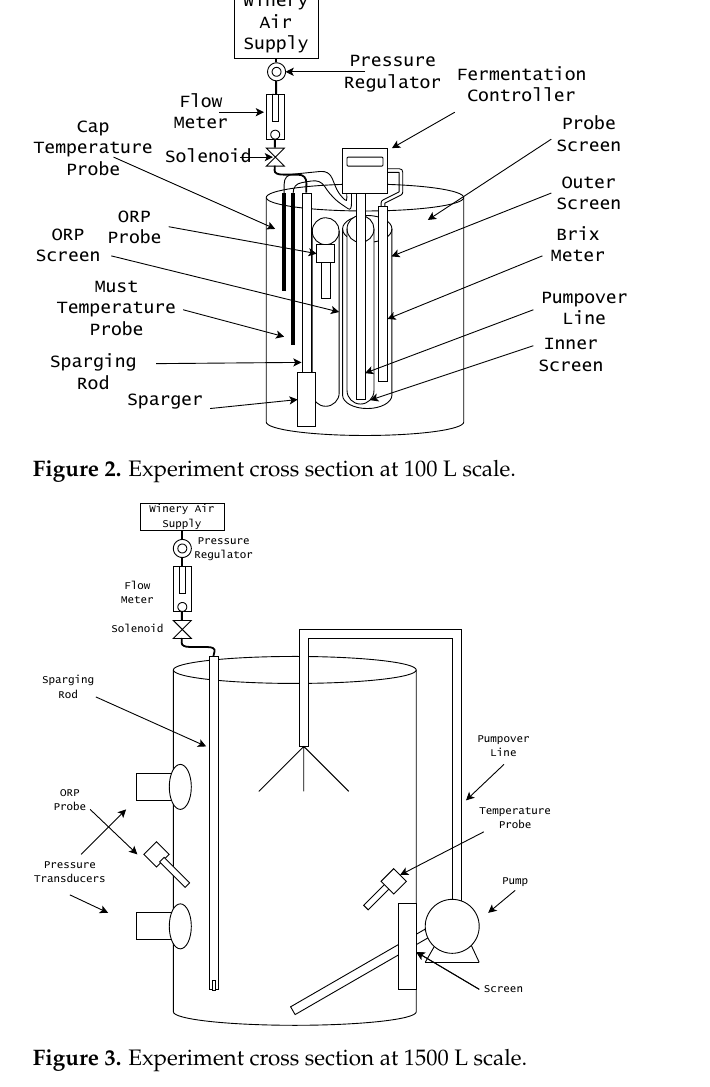
Figure 3. Experiment cross section at 1500 L scale.